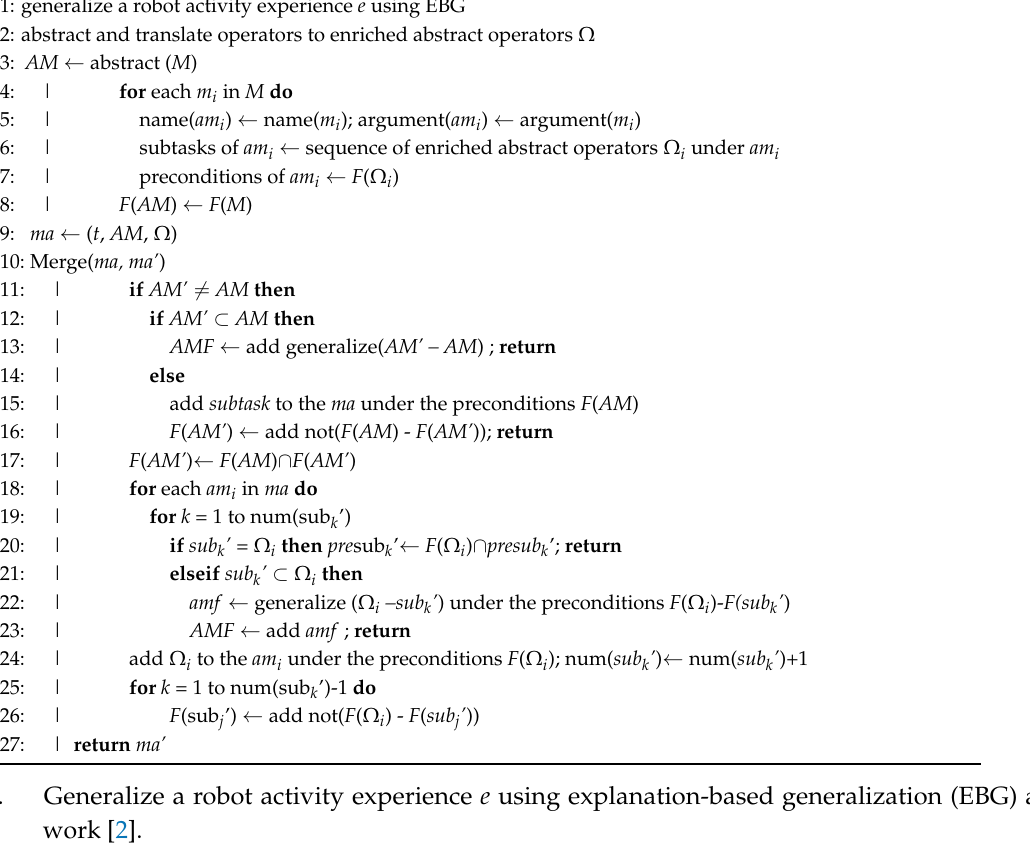
Algorithm 1 Learning activity schema with abstract